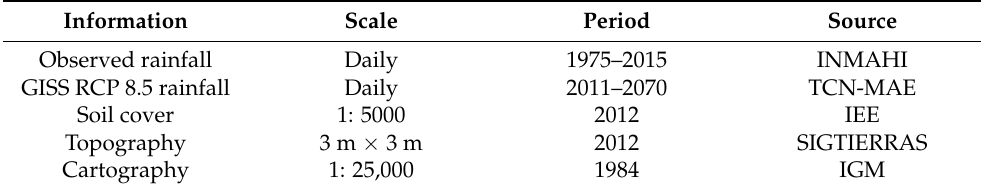
Table 3. Spatial and temporal information available.